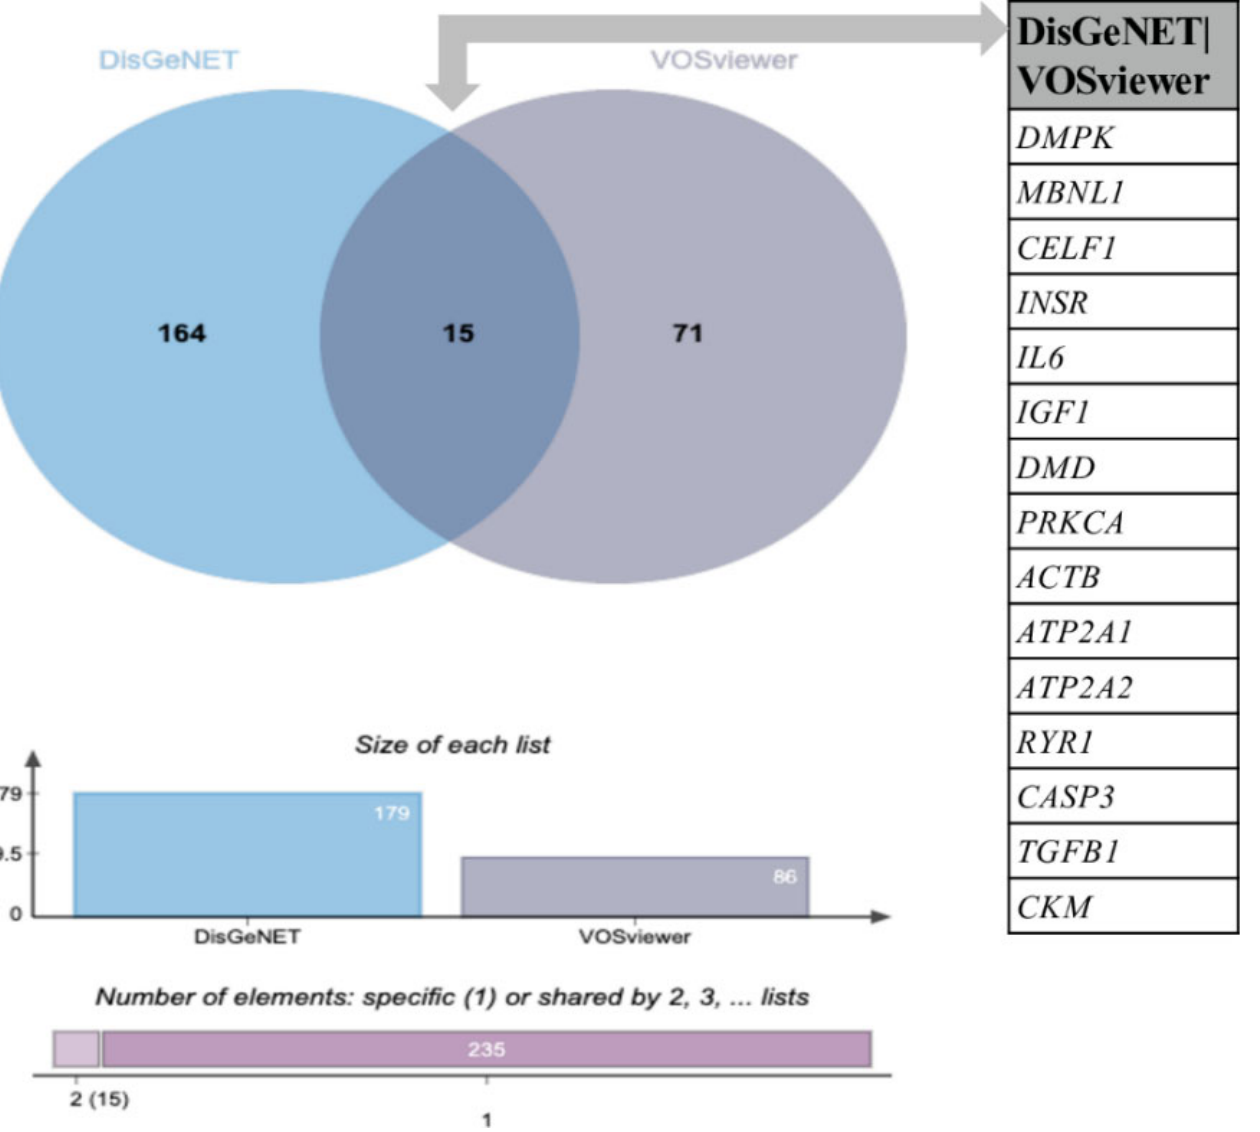
Figure 3. Venn diagram analysis of the DisGeNET and VOSviewer lists of genes. The Venn diagram shows an intersection between the DisGeNET and VOSviewer lists of genes. Each circle corresponds to an entry/gene list. Fifteen (15) common genes were found between the DisGeNET and VOSviewer lists; 164 are exclusive to the DisGeNET list, and 71 are exclusive to the VOSviewer list. The chart presented below the Venn diagram shows the list size and intersection size repartition. A compara- tive analysis was performed with jvenn software (http://jvenn.toulouse.inra.fr/app/example.html (accessed on 28 November 2022)).